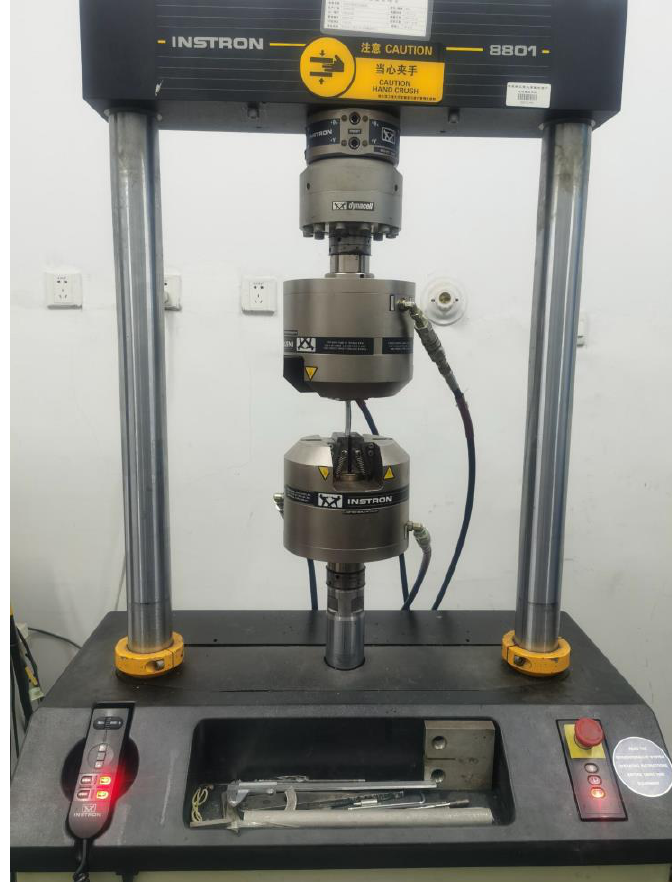
Figure 6. Electro-hydraulic servo fatigue testing machine.